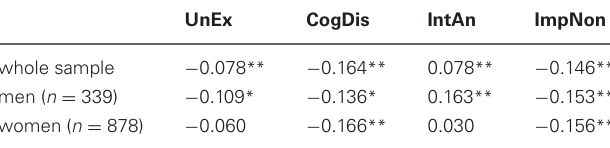
Table 4 | Correlations between age and the O-LIFE scales.